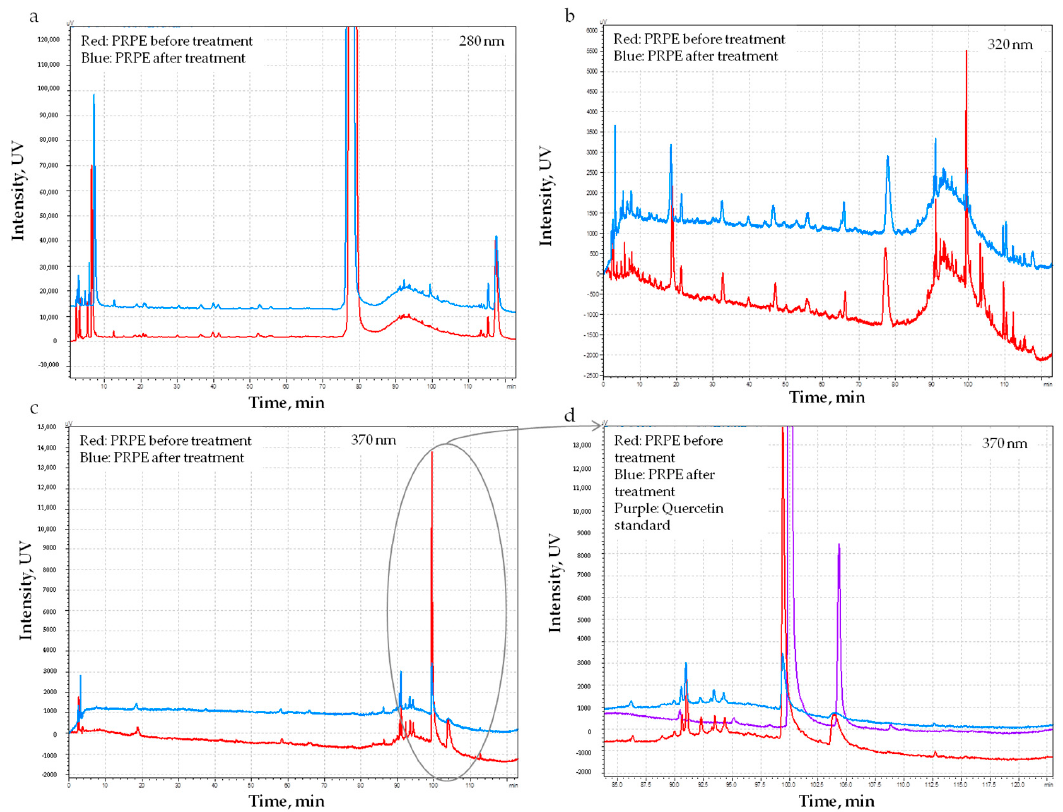
Figure 3. HPLC comparative analysis of PRPE before and after the treatment of the pericardium membrane at different wavelengths: 280 nm ( a ), 320 nm ( b ), and 370 nm ( c ). A marked decrease of quercetin peak has been reported after the treatment of the pericardium membrane ( d ).